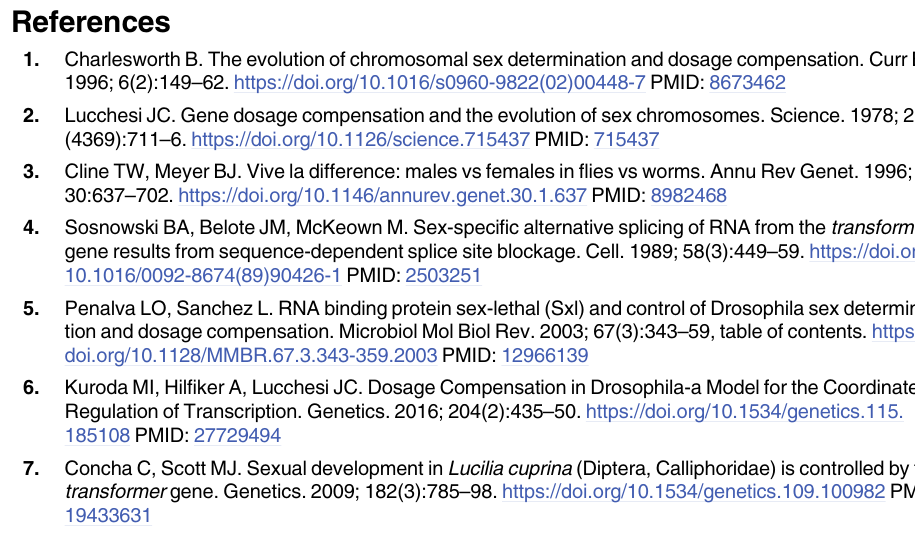
S2 Table. Oligonucleotide primers used in this study. S3 Table. RNAseq supplemental data. TPM values of autosomal and X-linked genes and X:A calculations. S4 Table. Raw Ct values for qPCR and qRT-PCR data shown in Figs 3–6.